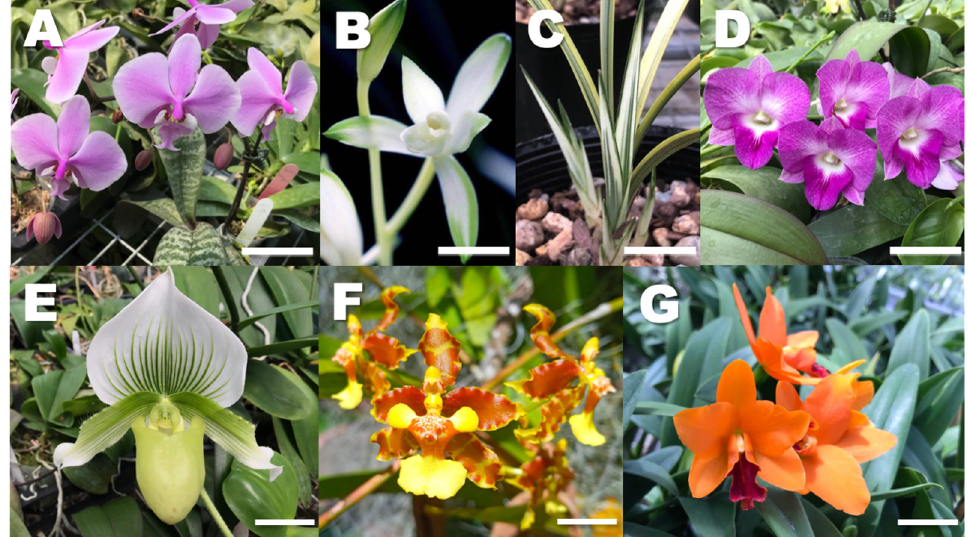
Figure 1. Representative contemporary orchid hybrids and species. Phalaenopsis schilleriana ( A ), a popular diploid species (2n = 38) used as parent in tetraploid hybrids, Cymbidium ensifolium ‘Variegata’, flowers ( B ), and variegated leaves ( C ), a prized diploid species (2n = 40) revered in traditional Chinese art, Dendrobium phalaenopsis ( D ), a diploid species (2n = 38) who may have crossed via unreduced gametes to D. discolor and thus produced the natural triploid hybrid D. superbens (3n = 54), Paphiopedilum Maudiae ( E ), a natural interspecific hybrid between P. callosum and P. lawrenceanum believed to be a tetraploid with a variable chromosome number (4n = 33–35), Oncidium stenotis ( G ), a species (probably diploid, 2n = 42) with large flowers and long stems, and with great horticultural potential Rhyncattleanthe Young-Min Gold ‘Golden Diamond’ ( G ), an intergeneric hybrid between Rhyncholaelia Schltr., Cattleya Lindl., and Guarianthe Dressler, and probably a diploid (2n = 40). Approximate scale bar: 2.5 cm ( A,C,D,E,G ), 1 cm ( B,F ). Photos taken by F. C. Chen ( A , D,E,G ) in Pingtung County, by Amigo Hsieh ( B , C ), in Tainan County, and by P. Bolaños-Villegas ( F ) at the Lankester Garden in Cartago, all in 2022.